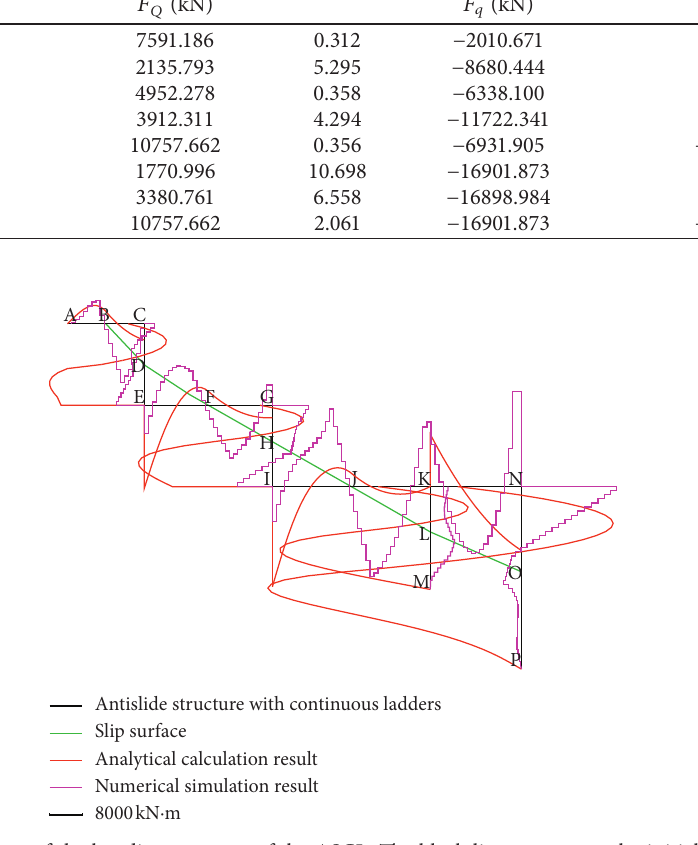
Figure 16: The comparative figure of the bending moment of the ASCL. The black lines represent the initial shape of the ASCL, and the green lines represent the slip surface. Taking the initial shape of the ASCL as a standard, the red lines represent the bending moment of the analytical calculations, while the pink lines represent the bending moment of the numerical